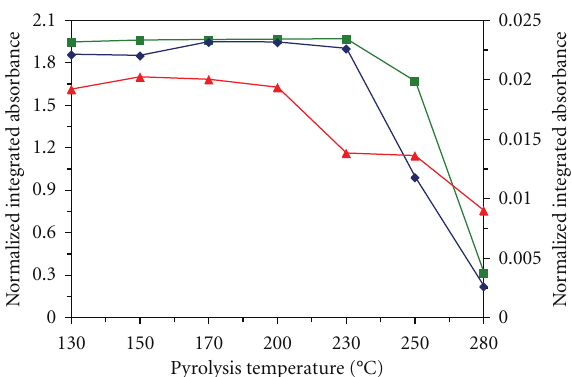
Figure 5: Pyrolytic curves for solid samples in presence Re surface modifier. left axis: (cid:5) plant, (cid:3) soil II; right axis: (cid:2) CRM CBW 07405.